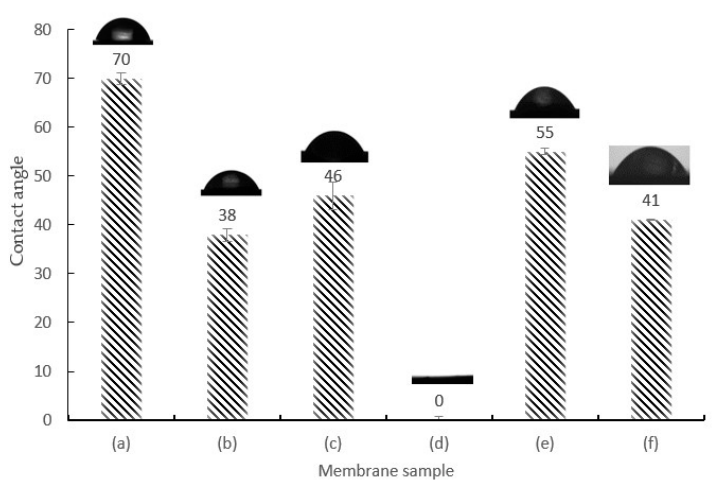
Figure 4. Wettability results of ( a ) PES 0, ( b ) PES 1, ( c ) PES 2, ( d ) PES 3, ( e ) PES 4, and ( f ) PES 5 membranes.